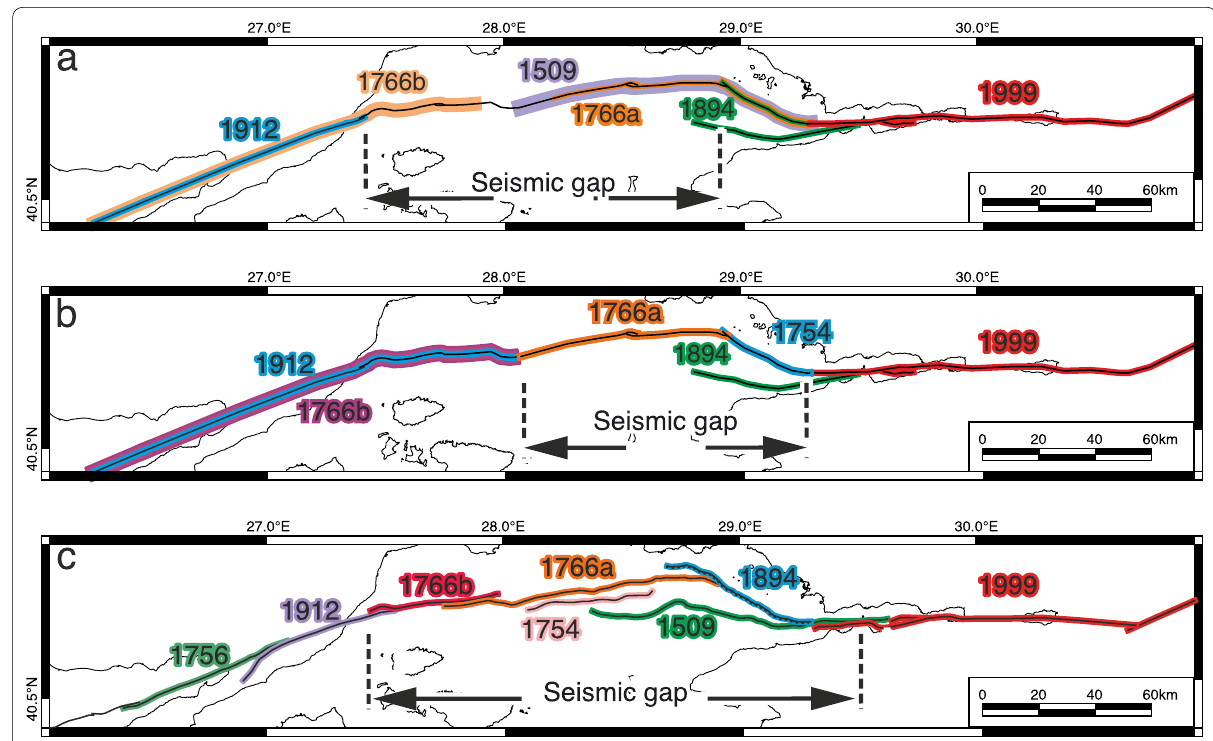
Fig. 2 Rupture zones of the historical earthquakes and the seismic gap based on revised historical earthquakes. a Parsons (2004), b Armijo et al. (2005) and Pondard et al. (2007), c Yaltırak (2015) and Bulut et al.